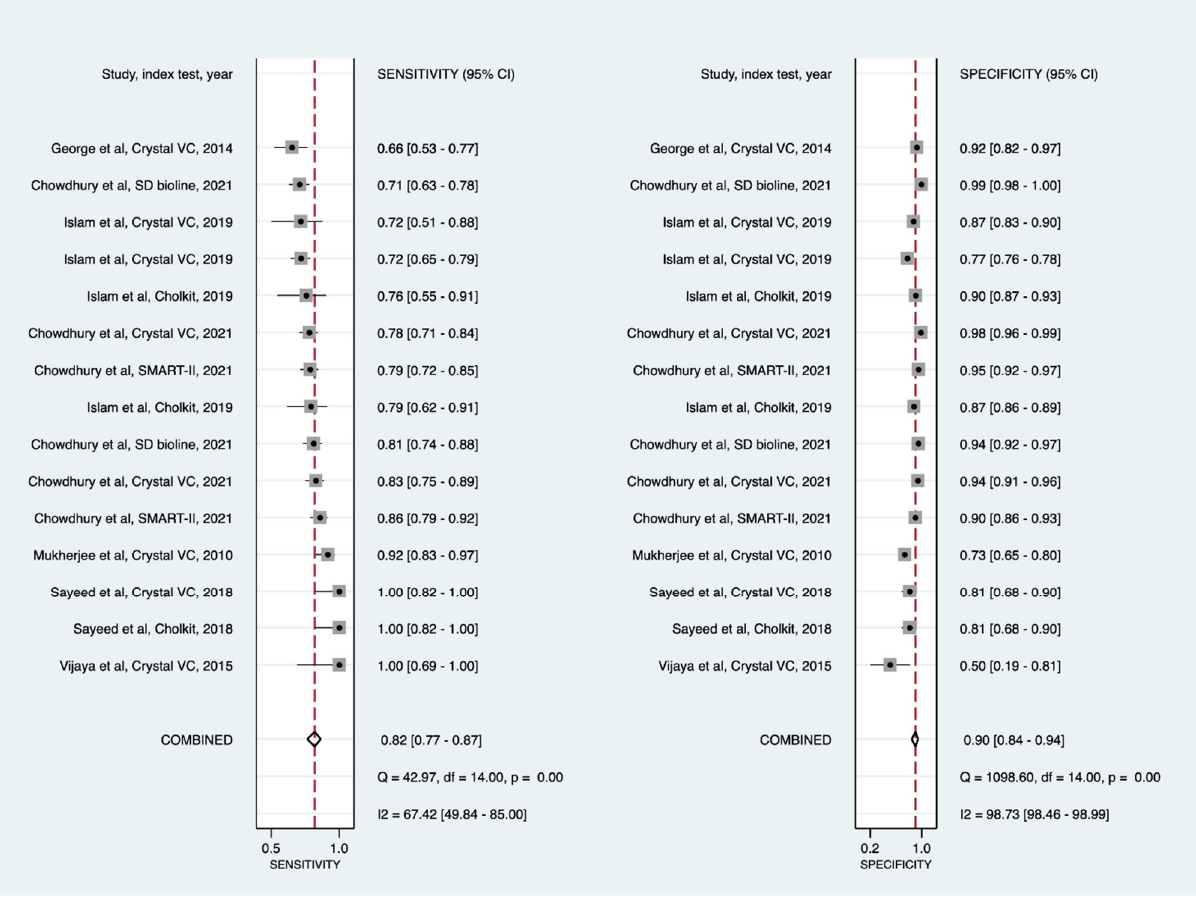
Figure 5. Forest plots of the sensitivities and specificities of cholera rapid diagnostic tests (direct stool testing) with their 95% confidence intervals. This sub-analysis was restricted to studies conducted in Asia (Bangladesh and India). CI = confidence interval.